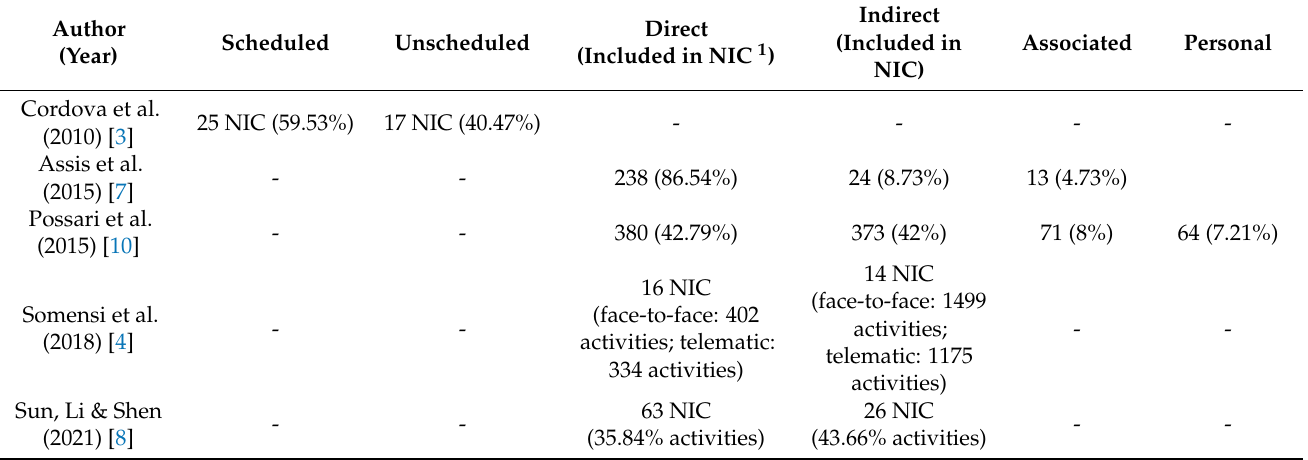
Table 3. Type of activities.